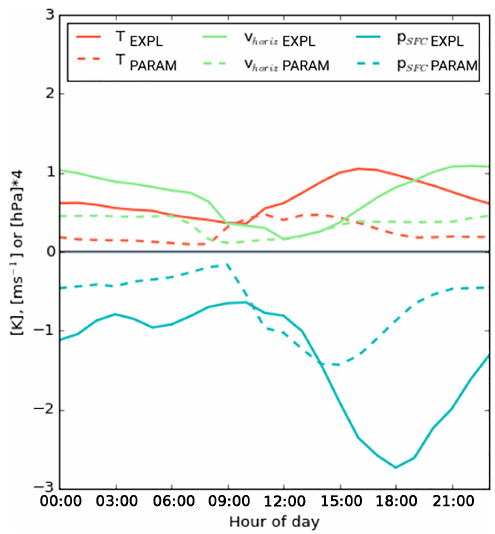
Figure 11. Maximum hourly value extracted from south–north dis- tributions of July 2006 averaged diurnal cycles in Figs. 10 and 13 for T and v horiz at 925hPa as well as p sfc (according to